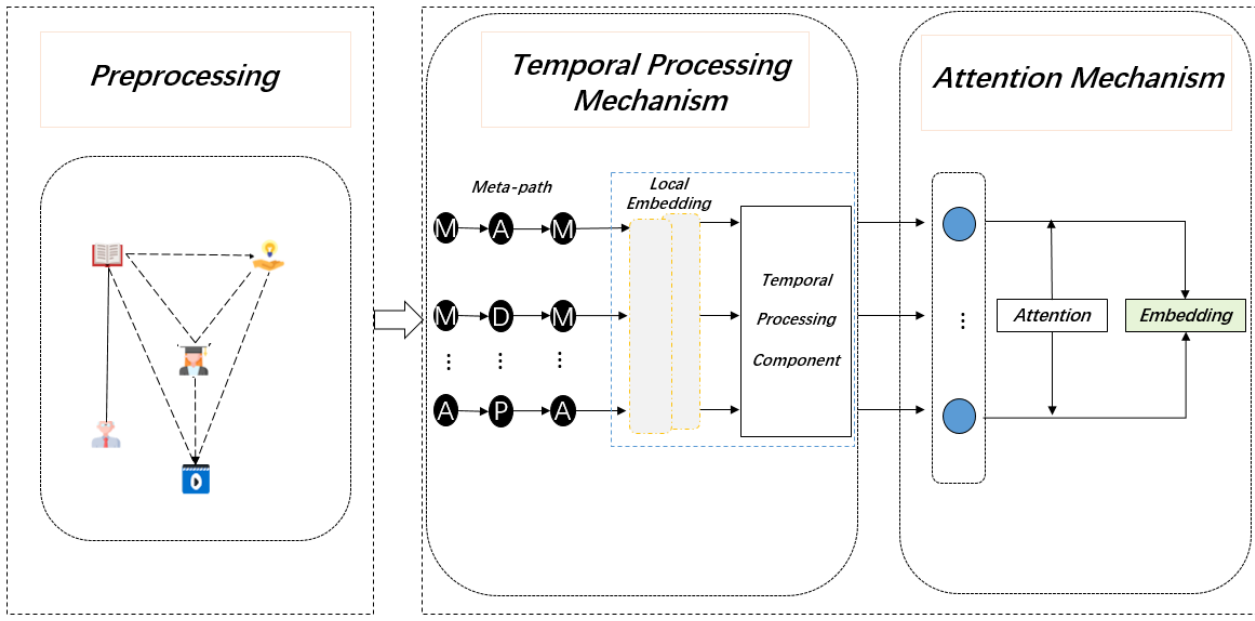
Figure 2. The Framework of the MRDE model.